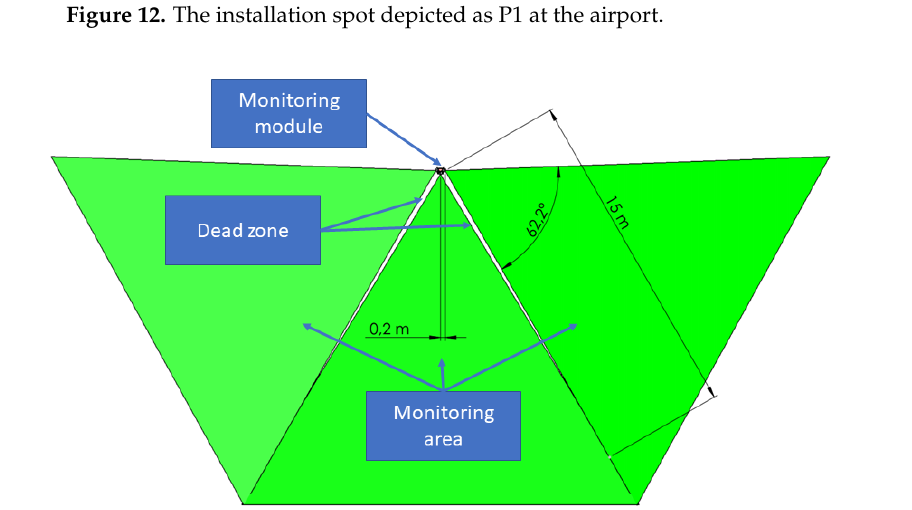
Figure 13. The monitoring area and dead zone configuration of the system prototype consisting of three monitoring